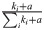
Testing W(x) by simulated attachments.The property x here corresponds to the number of children, and the full symbols connected by continuous lines show the measured W(x) for random attachment (independent of x) in orange (circles), and for preferential attachment with an additive constant (i.e. when a newly added node connects to node i with a probability ki+a∑iki+a where a is an arbitrary constant) in blue (squares). Dashed lines correspond to the analytic mean for W(x), whereas the shaded areas indicate the standard deviation around the mean.